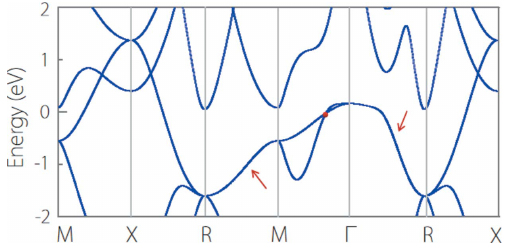
Figure 10 Electronic band structure of YCd. The red dot shows the type-II band crossing point at the M – (cid:2) path. The red arrows point to the doubly degenerate bands along the whole R – M and (cid:2) – R